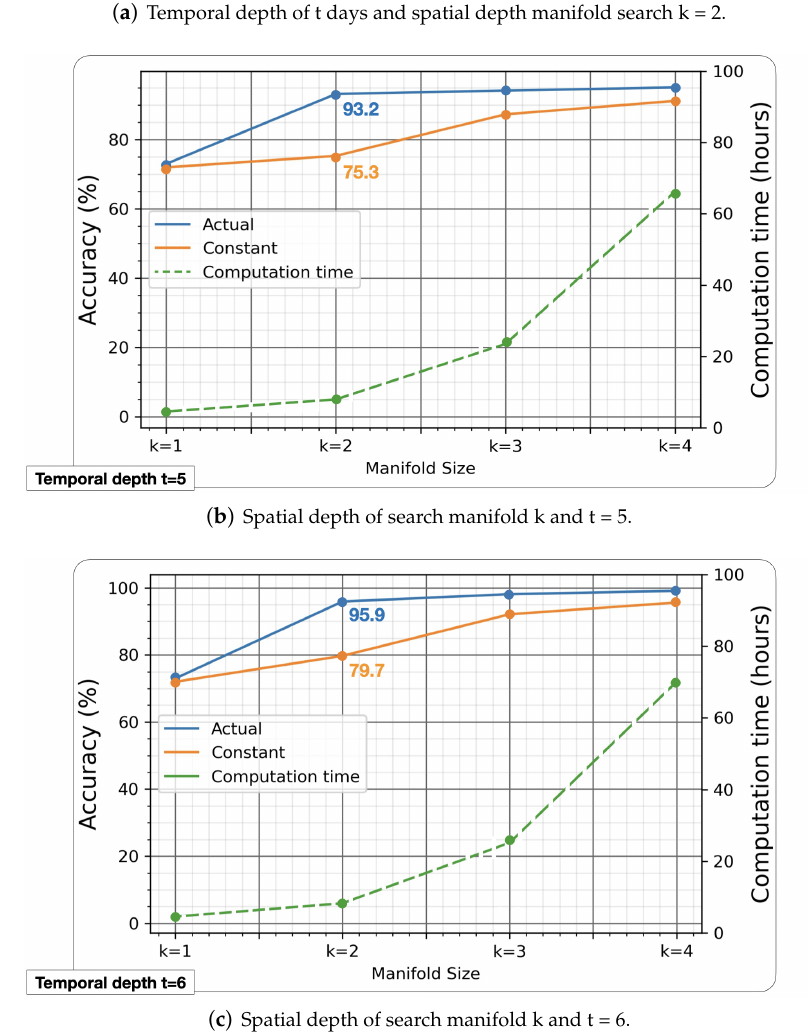
Figure 8. Summary of